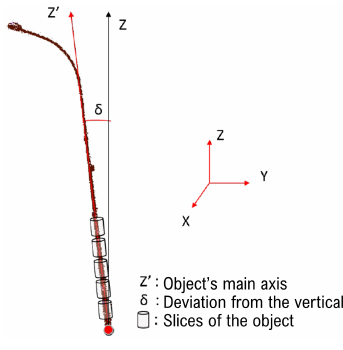
Figure 4. Inserting point calculation.